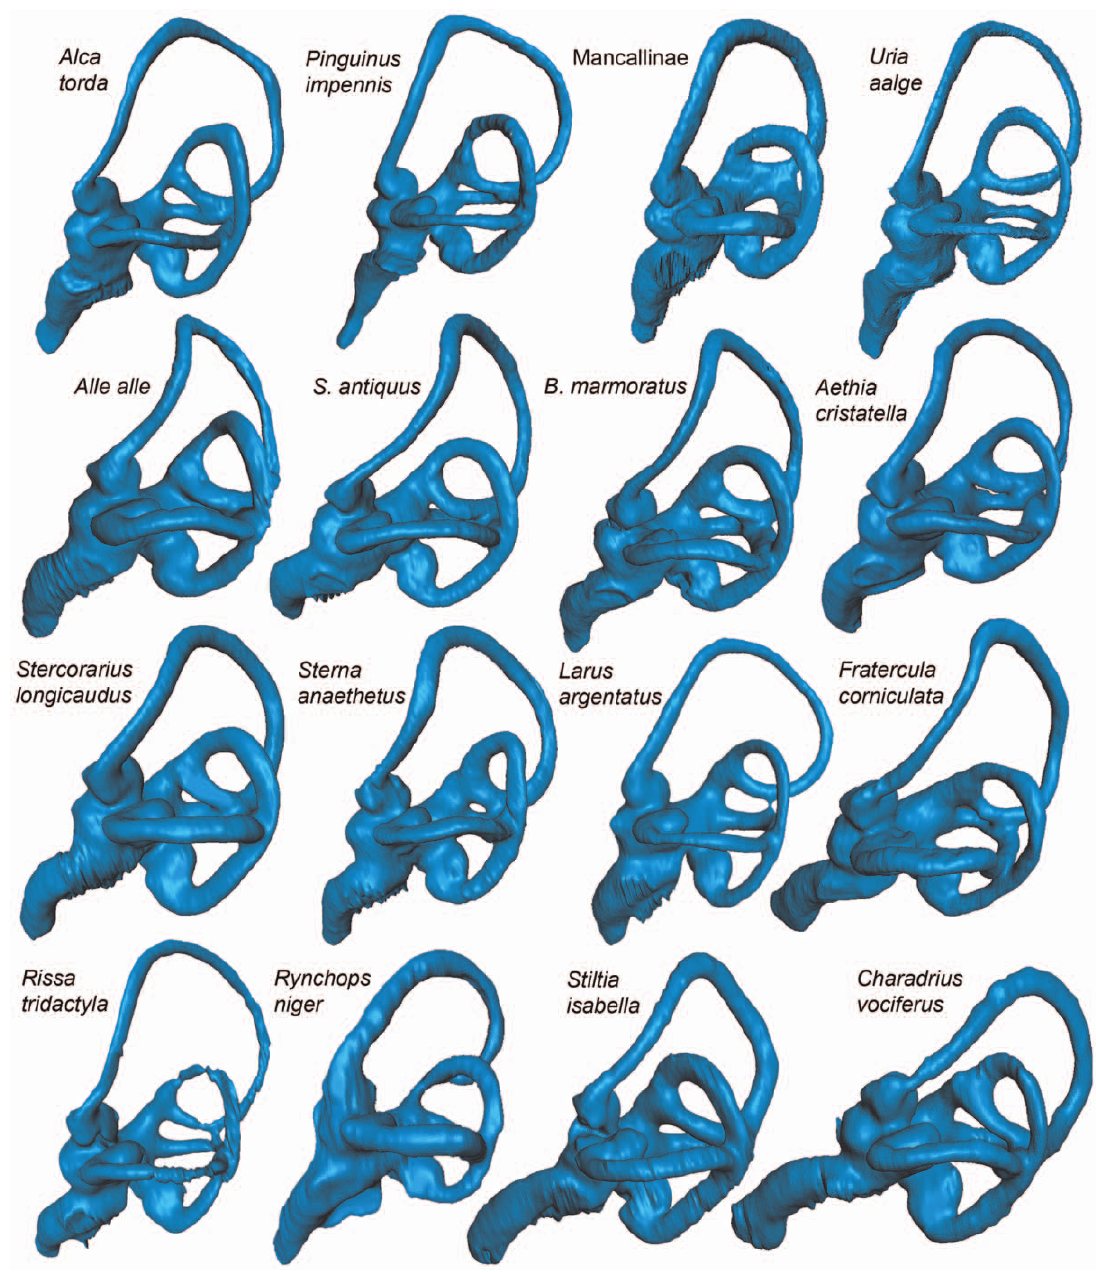
Figure 14. Left endosseous labyrinths of sampled taxa in lateral view (not to scale for comparison). Note that compression of the semicircular canals is often difficult to visualize without being able to manipulate reconstructed canals in 3-D.